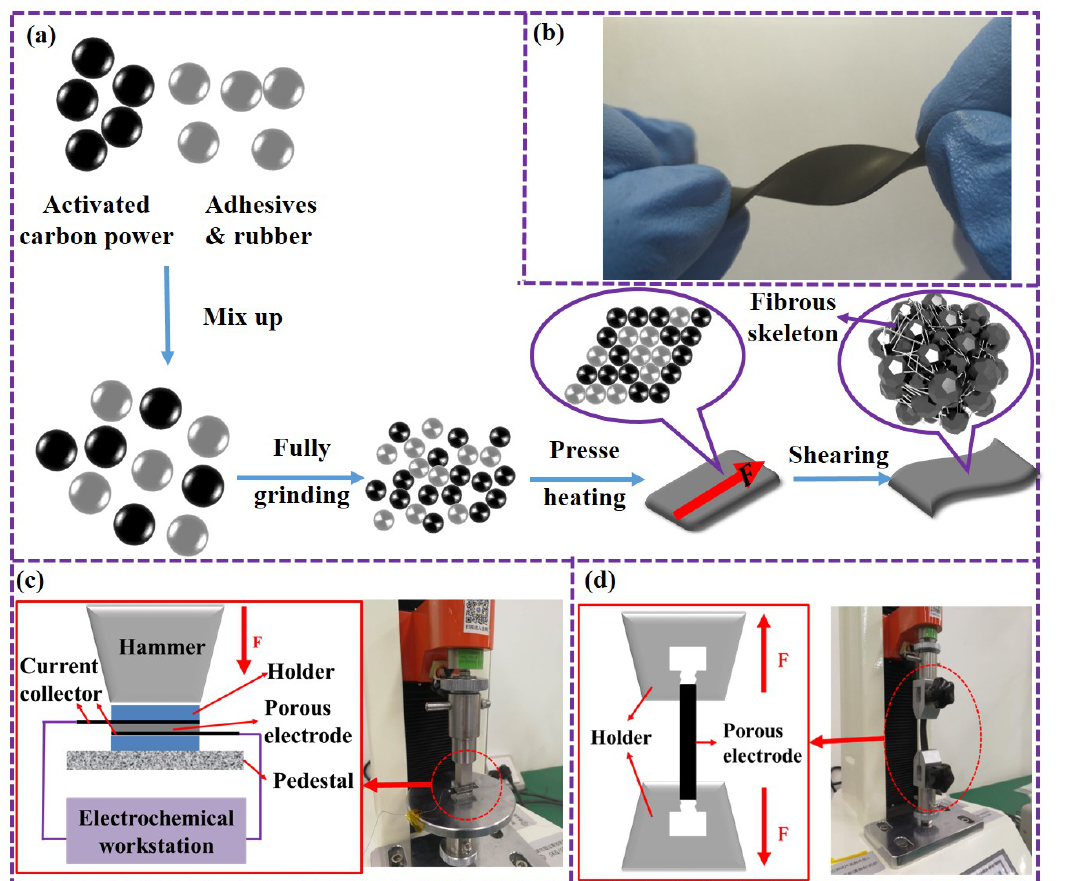
Figure 2. Preparation and testing of the porous electrodes. ( a ) Preparation process for microstructure formation. ( b ) Flexibility of the electrode under extreme torsion. ( c ) Experimental platform for piezoresistive testing. ( d ) Experimental platform for tensile